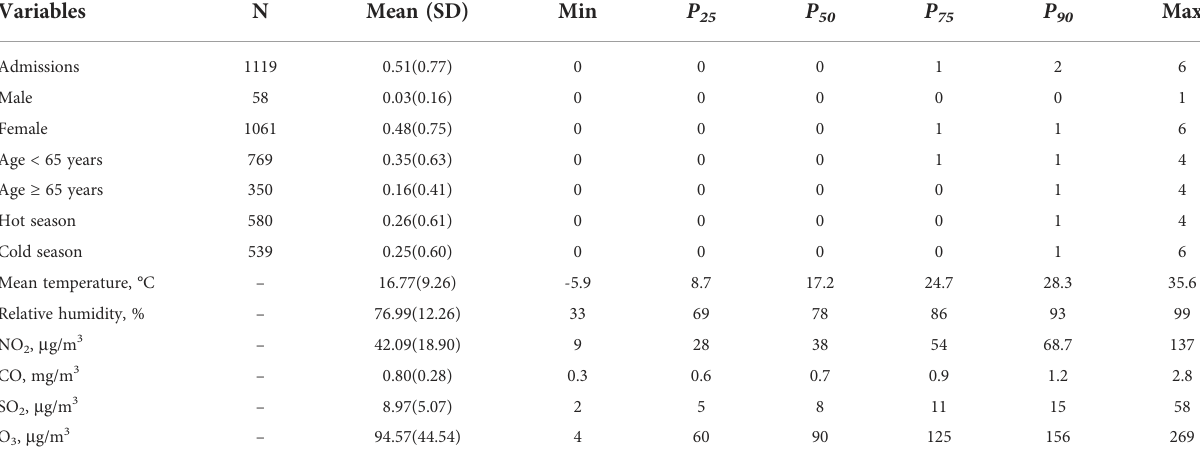
TABLE 1 The basic information on SS admission, meteorological variables and gaseous pollutants in Hefei City from 2016 to